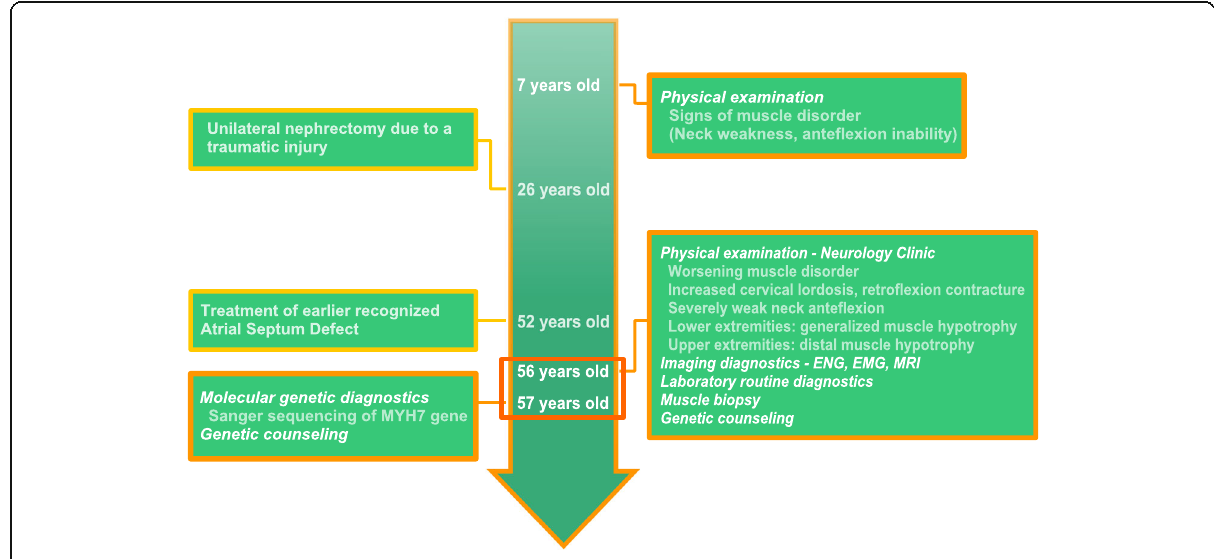
Fig. 1 Relevant history of the patient organized into a